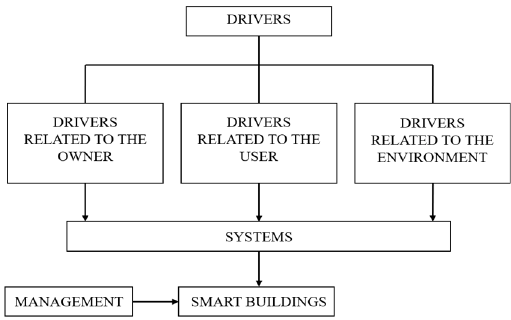
Figure 3. Brief flowchart of drivers and their relationships.